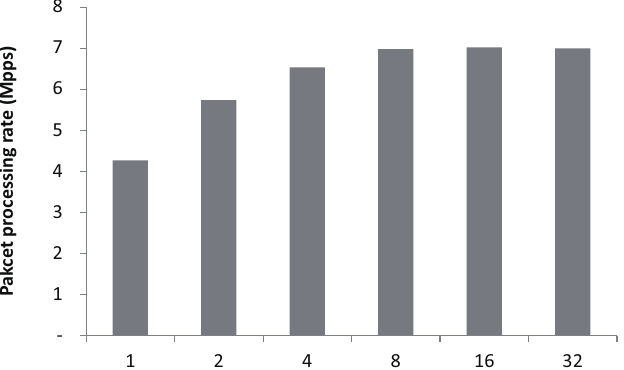
Figure 7. Packet processing performance of SP2 increases as the batch size increases from 1–8. When the batch size exceeds eight, there is no further performance improvement.